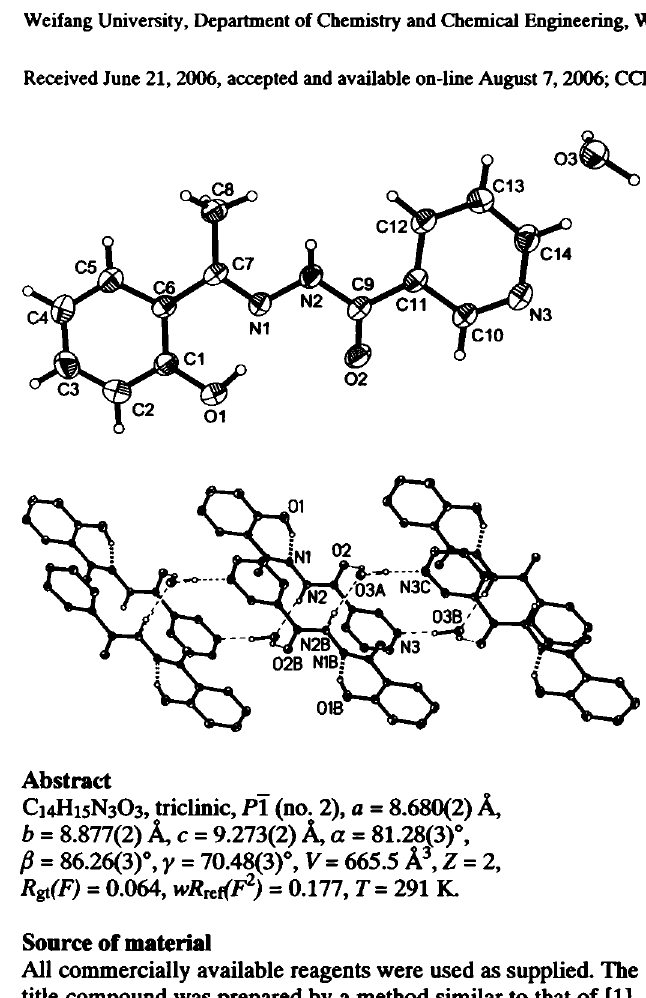
Table 2. Atomic coordinates and displacement parameters (in A z